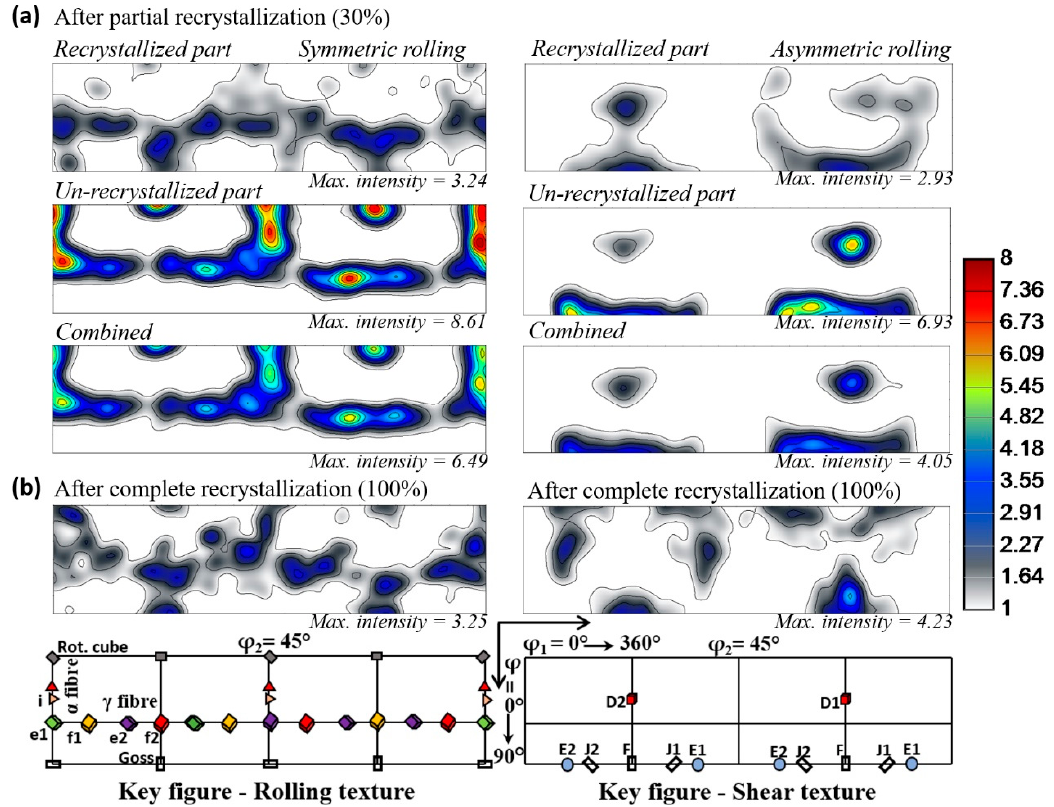
Figure 17. Sections of ODF for partial ( a ) and complete recrystallization ( b ) in symmetric and asymmetric rolling.